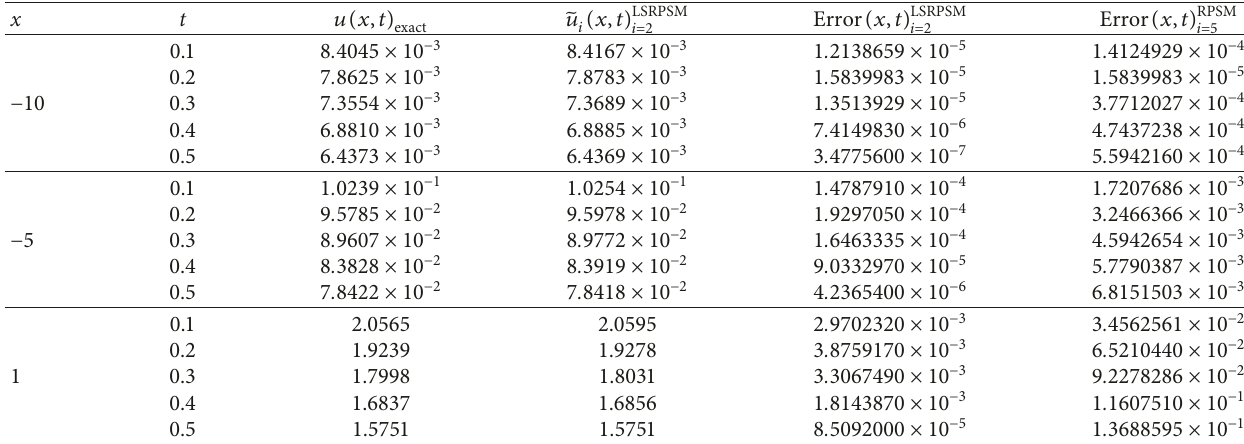
Figure 1: 3D graphics of exact and approximate solutions. (a) 􏽥 u ( x, t ) Table 1: Absolute errors by LSRPSM and RPSM for α � 1.